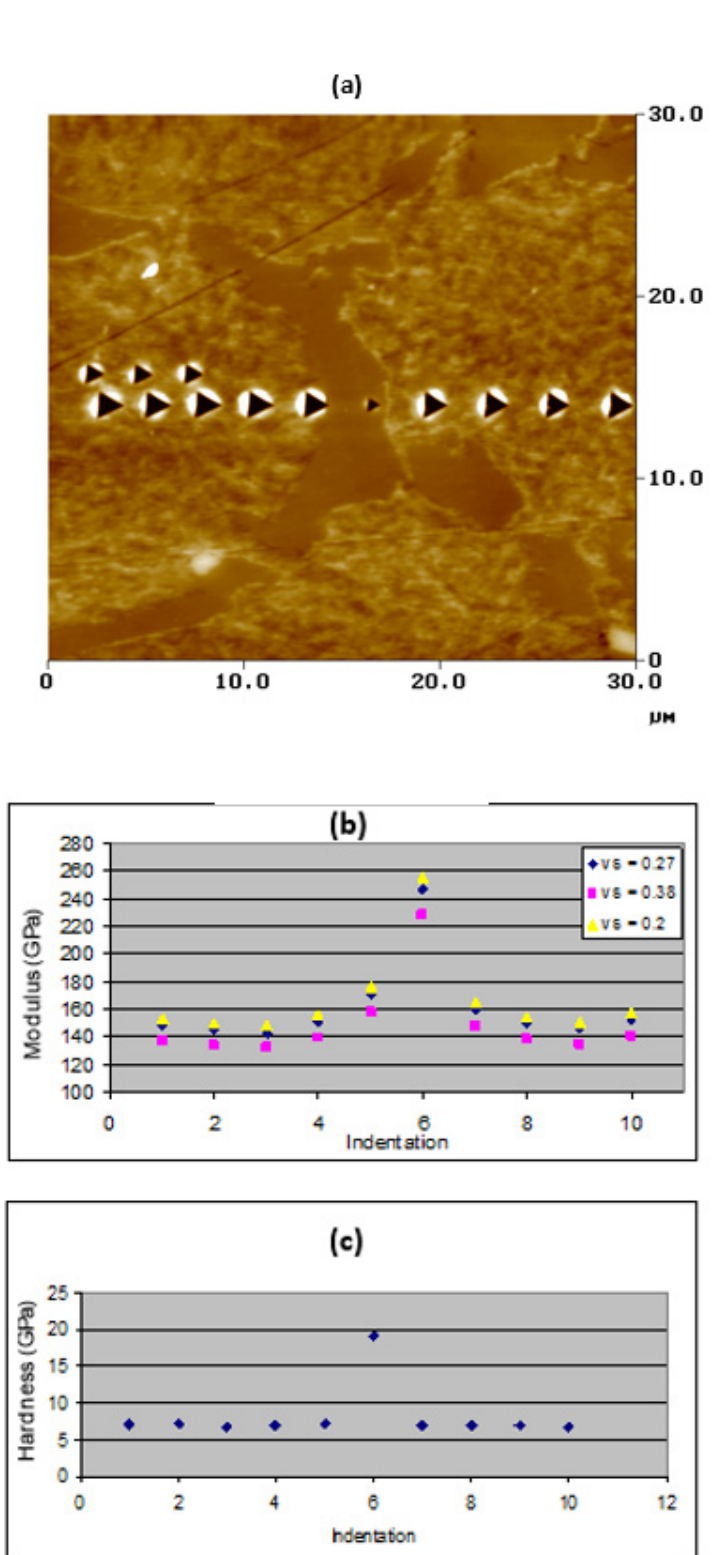
Figure 10. Data for ( b ) modulus and ( c ) hardness of Nb ss and Nb 5 Si 3 in NV1-AC for ( a ) a nano-indentation line scan crossing a Nb 5 Si 3 grain located between two Nb ss grains. The three smaller nano-indentations on the left-hand side of ( a ) above the row of lager nano-indentations were produced with a load of 4000 μ N.